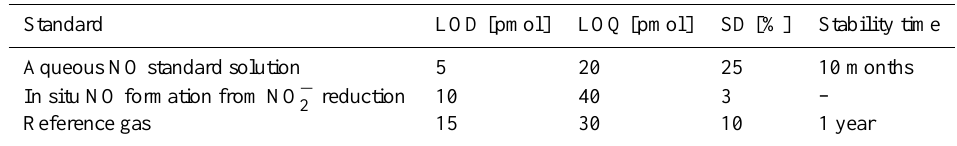
Table 2. Overview of the limit of detection (LOD), the limit of quantification (LOQ), the standard deviation (SD) and the estimated stability time of the applied standards types. Standard LOD [pmol] LOQ [pmol] SD [%] Stability time Aqueous NO standard solution 5 Reference